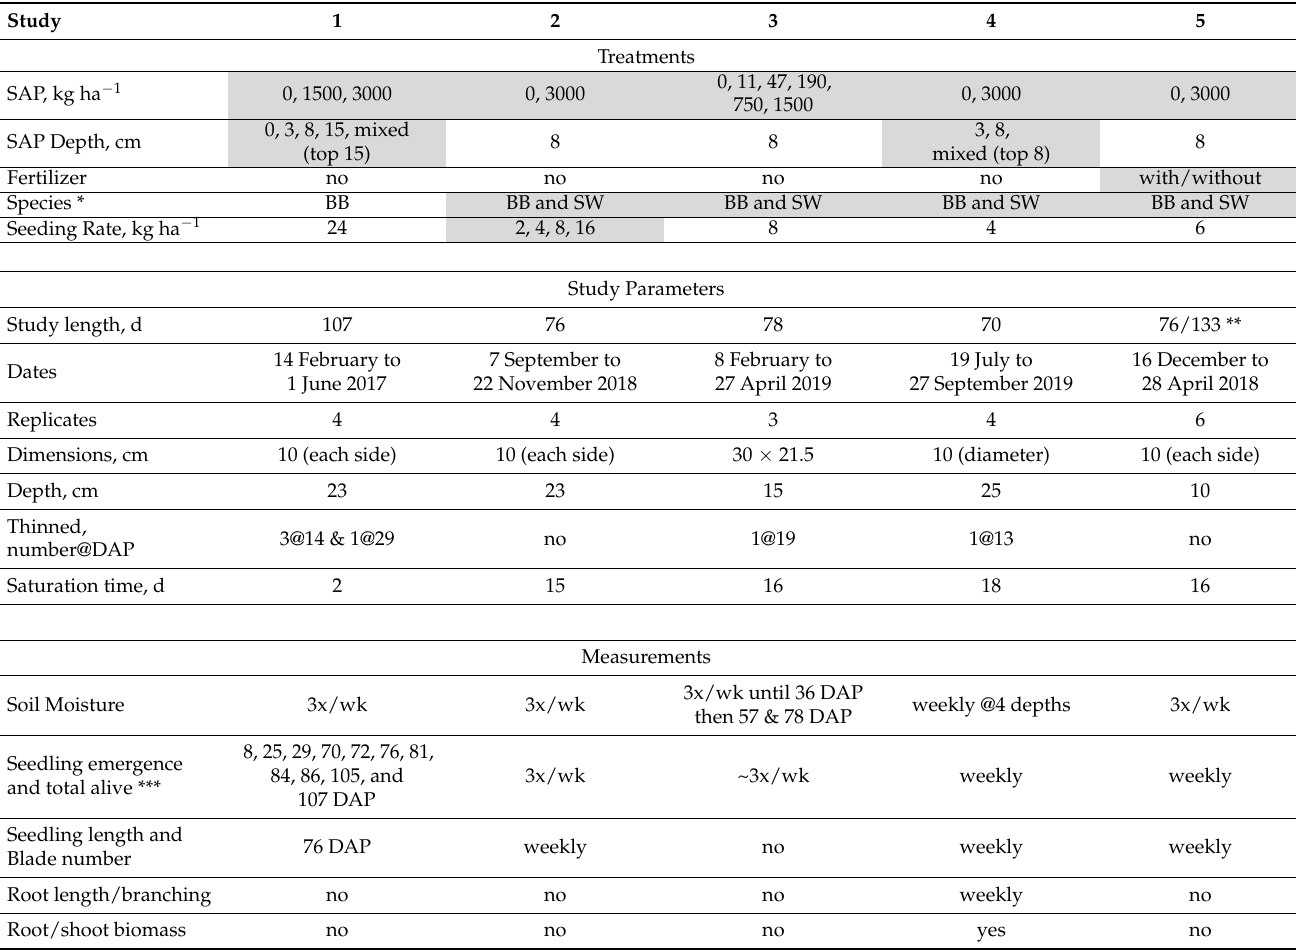
Table 1. Five glasshouse study treatments, parameters, and measurements. Gray squares in the treatments section indicate a treatment parameter for that